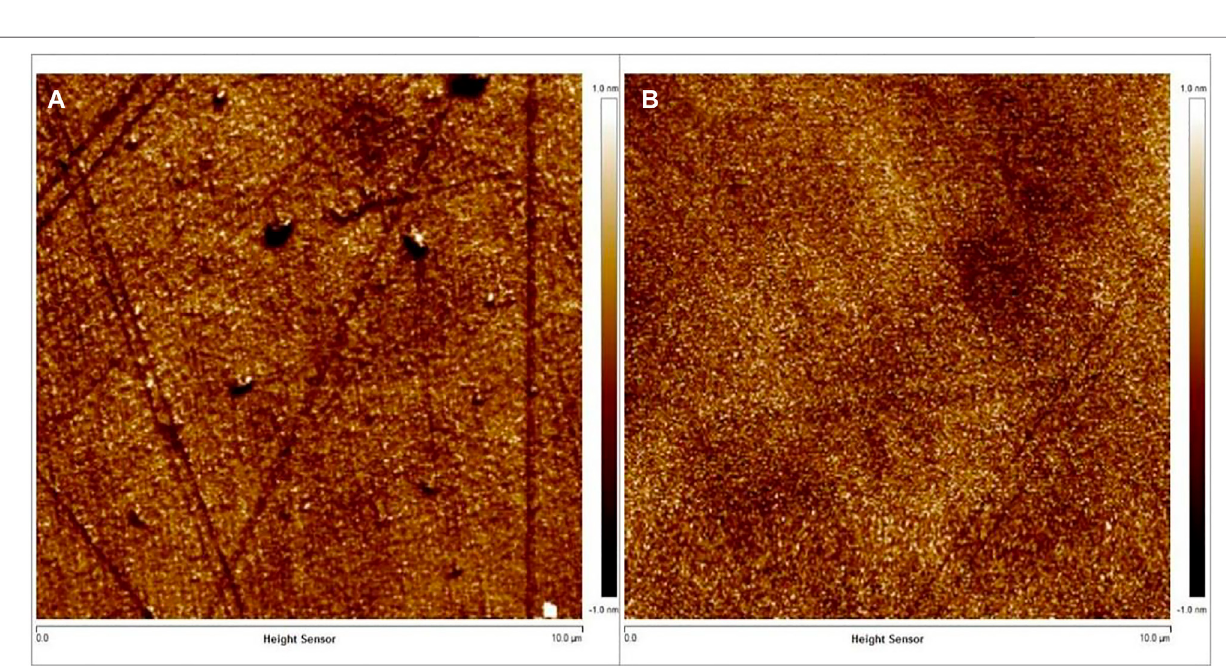
Frontiers in Materials |